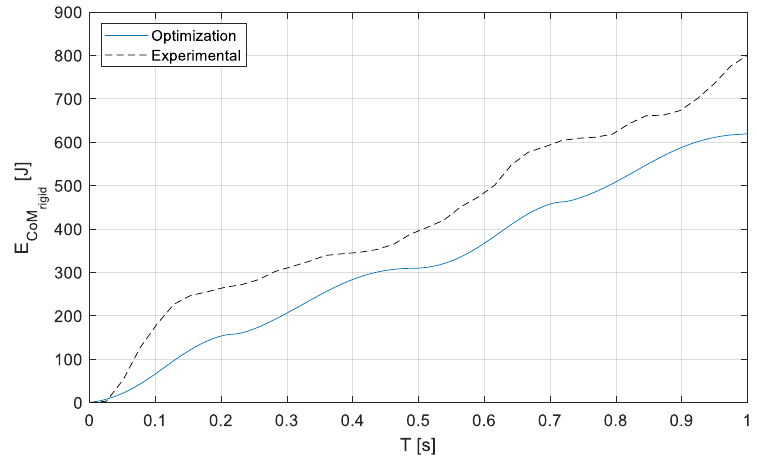
Figure 15. Mechanical energy comparison between experimental data and the optimal solution. It is clear how the resulting energies are comparable.